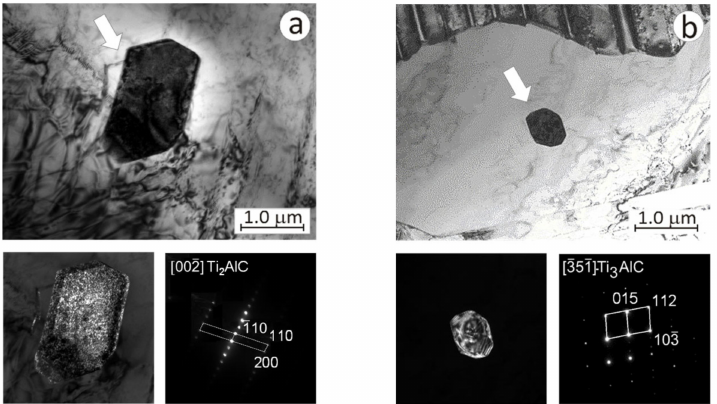
Figure 6. Microstructure and diffraction pattern of carbide precipitate in Ti-45Al-5Nb-2Cr-1Mo- 0.5(B,C)-0.2Si ( a ) and Ti-45Al-8Nb-0.5(B,C) ( b )